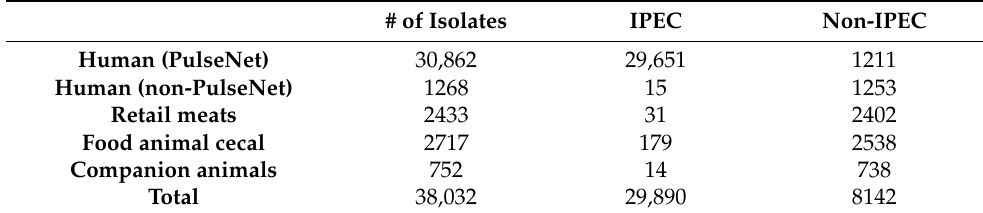
Table 1. Distribution of non-IPEC strains by isolation source.